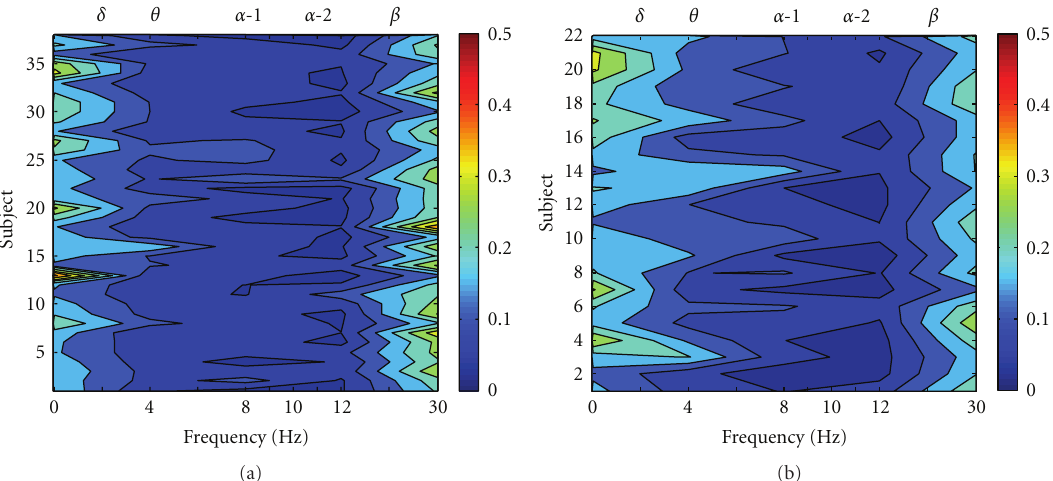
Figure 4: Relative power distribution in various frequency bands for all the datasets. (a) Control group. (b) Mild cognitive impaired subjects.